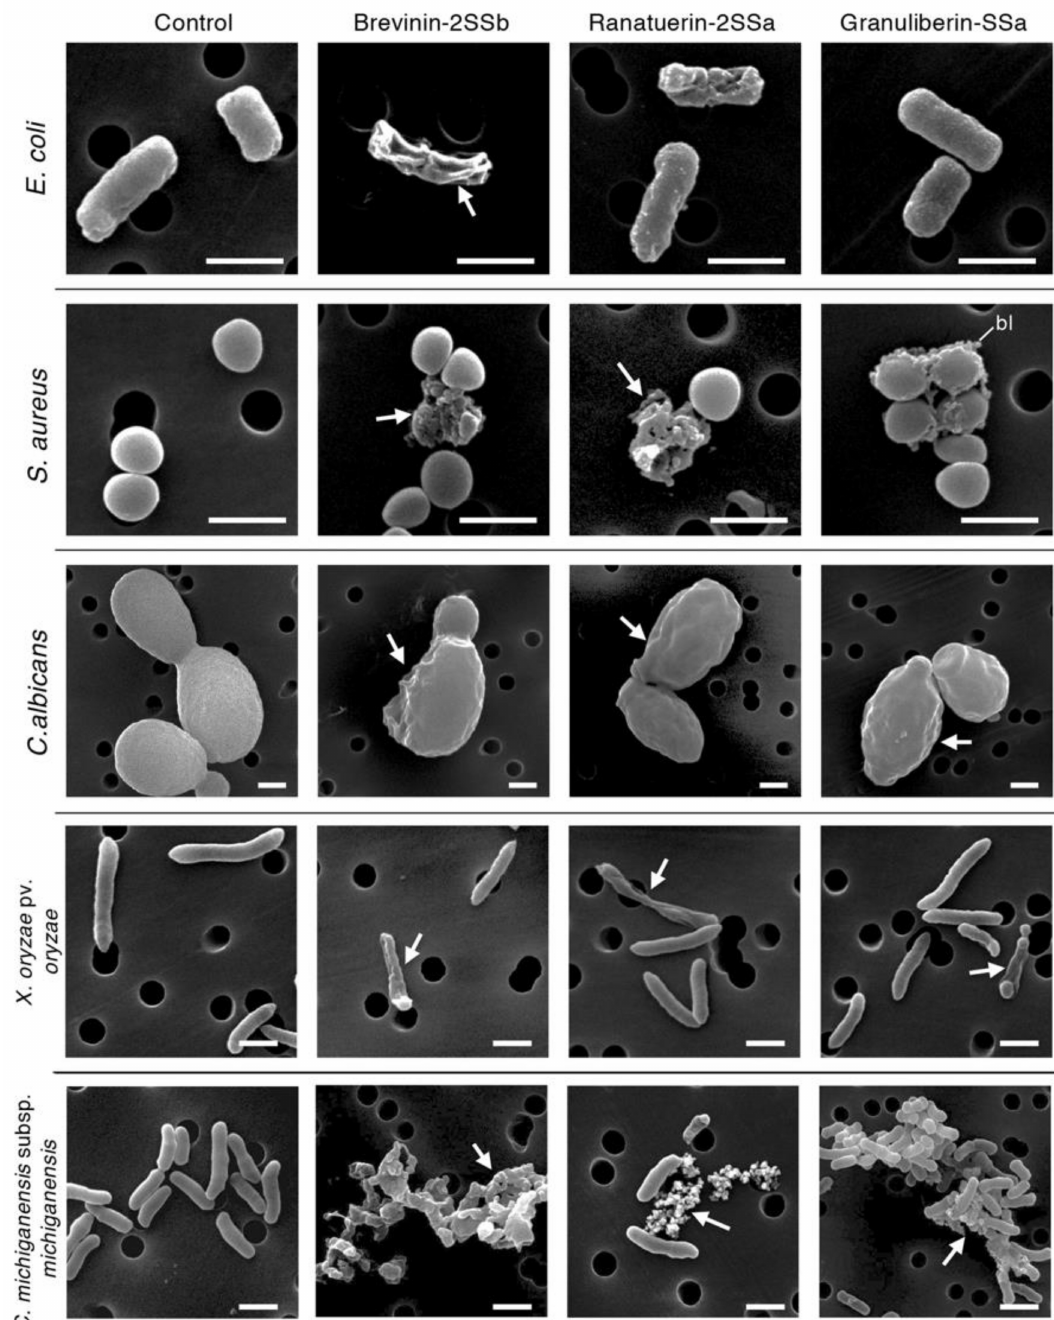
Figure 5. Scanning electron microscopy (SEM) analysis of bacterial and fungal cells following treatment with brevinin-2SSb, ranatuerin-2SSa, or granuliberin-SSa. Aliquots of E. coli , S. aureus , C . albicans , C. michiganensis subsp. michiganensis , and X. oryzae pv. oryzae cultures at the midlogarithmic growth phase were incubated with brevinin-2SSb, ranatuerin-2SSa, granuliberin-SSa, or myoglobin (control) at 128 µ g / mL for 1 h at room temperature and were then examined using SEM analysis. Abnormally shaped cells indicating cell surface destruction (arrows) or bleb formation (bl) are visible in each panel of brevinin-2SSb-, ranatuerin-2SSa-, and granuliberin-SSa-treated cells when compared with myoglobin-treated cells. Scale bars represent 1 µ